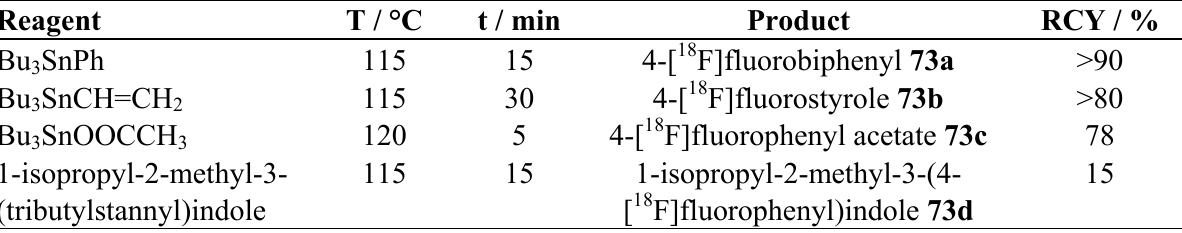
Table 1. Selected conditions and RCYs of the Pd-mediated cross-coupling with